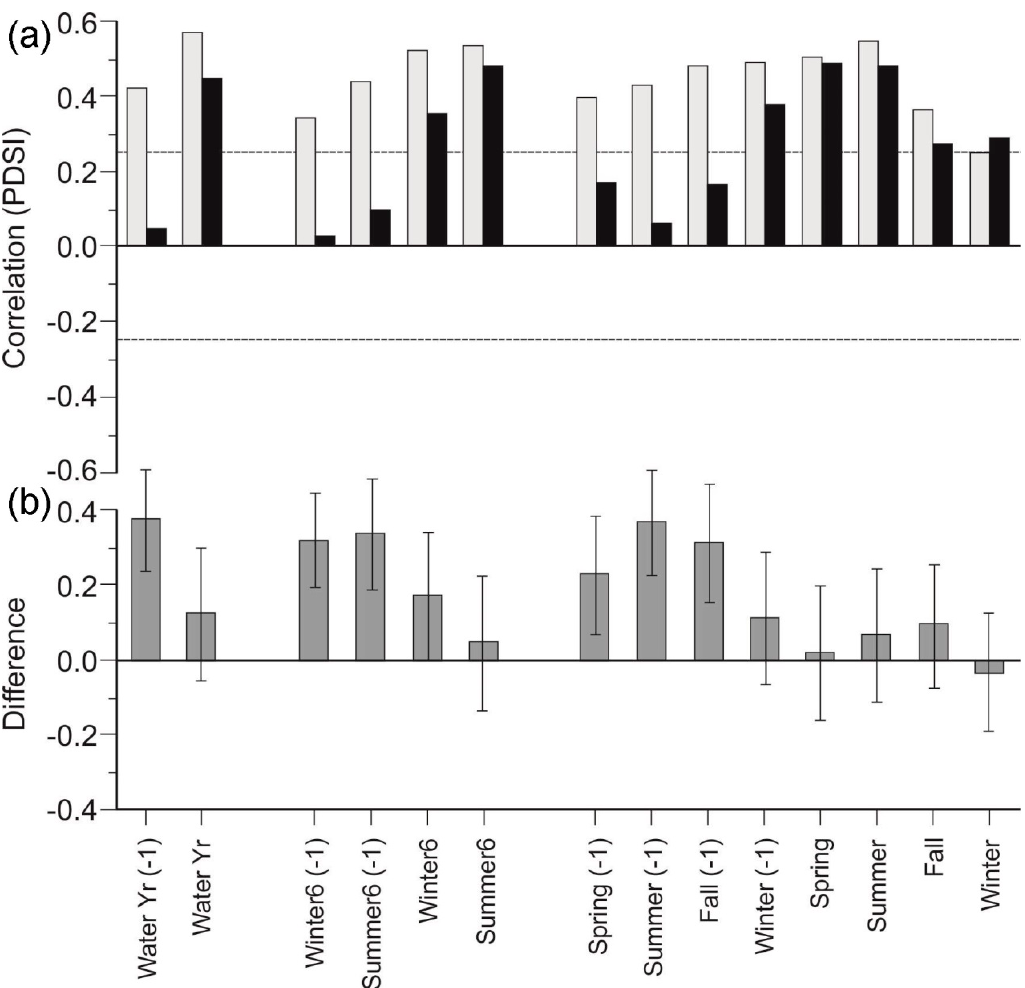
Figure 2. ( a ) Correlations between radial growth index of Douglas-fir (light gray) and Oregon white oak (solid) and seasonal values of the PDSI (see text for time windows). The horizontal dashed lines indicate the threshold for significance at the 95% confidence level. ( b ) Growth–climate response differences for the two species. Positive values indicate that Douglas-fir is more positively correlated to PDSI than Oregon white oak during that season. The error bars indicate the 95% confidence limit on the difference.